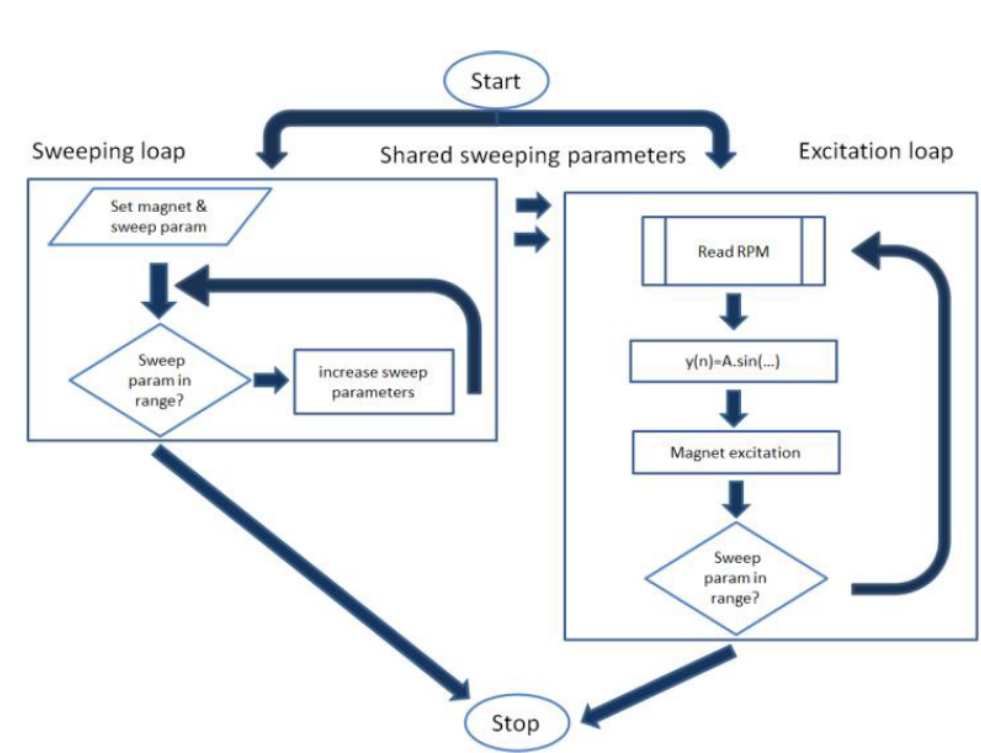
Figure 7. Measurement and excitation algorithm.